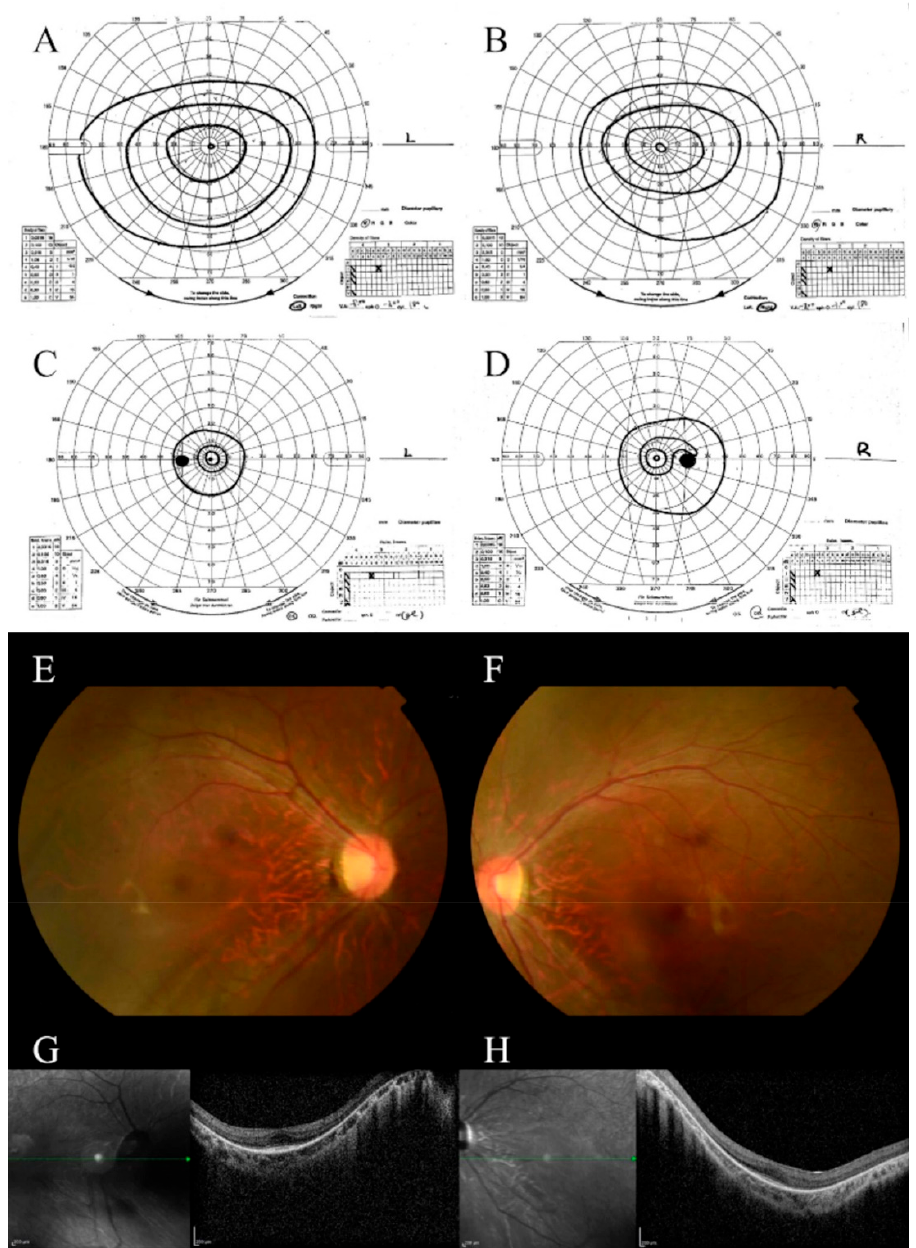
Figure 1. Clinical features of case 1. The visual field examined at the age of 9 years: ( A ) left eye; ( B ) right eye. Visual field examined at the age of 14 years: ( C ) left eye; ( D ) right eye. The visual field was progressively constricted. Fundus photograph obtained at the age of 9 years: ( E ) right eye; ( F ) left eye. Fundus photography showed poor retinal color and narrowing of the retinal blood vessels. OCT images obtained at the age of 10 years: ( G ) right eye; ( H ) left eye. Although OCT images were poor due to nystagmus, retinal thinning and EZ line disappearance were observed.